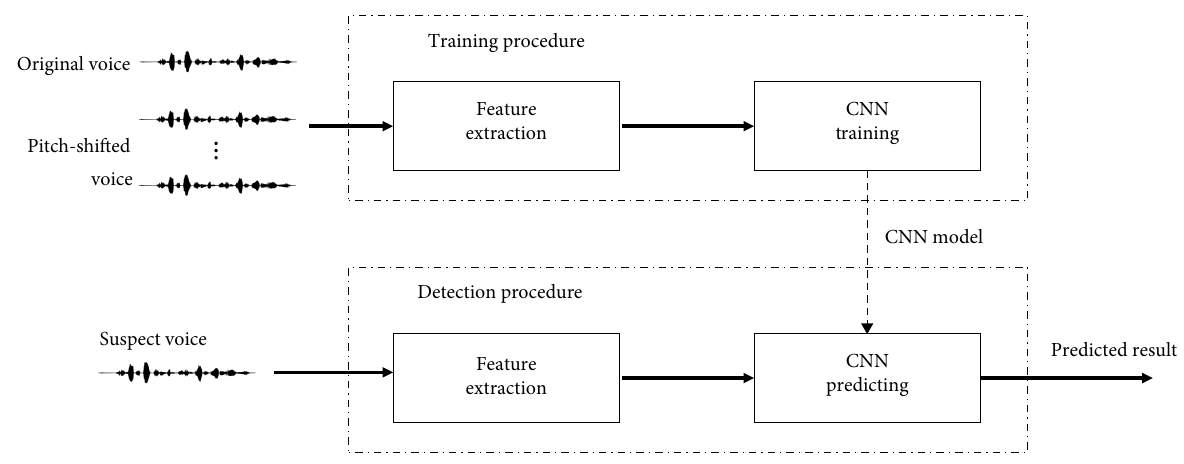
Figure 3: Diagram of the proposed pitch-shifting identification